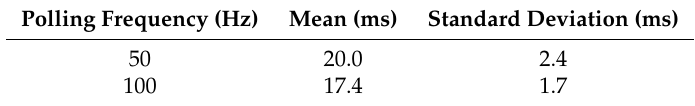
Table 1. Time needed for a sample to travel back and forward the board via Slicer (at 9600